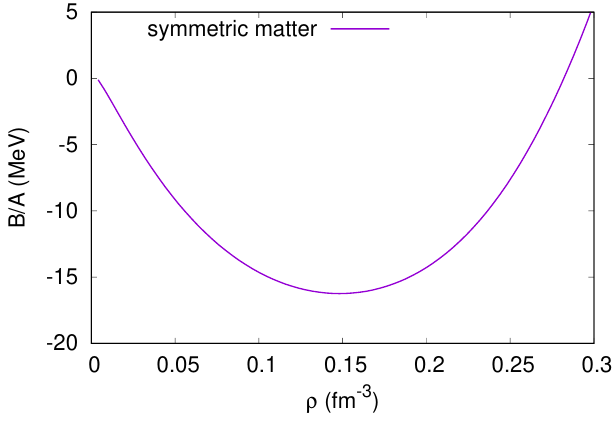
Figure 6. Nuclear matter binding energy per